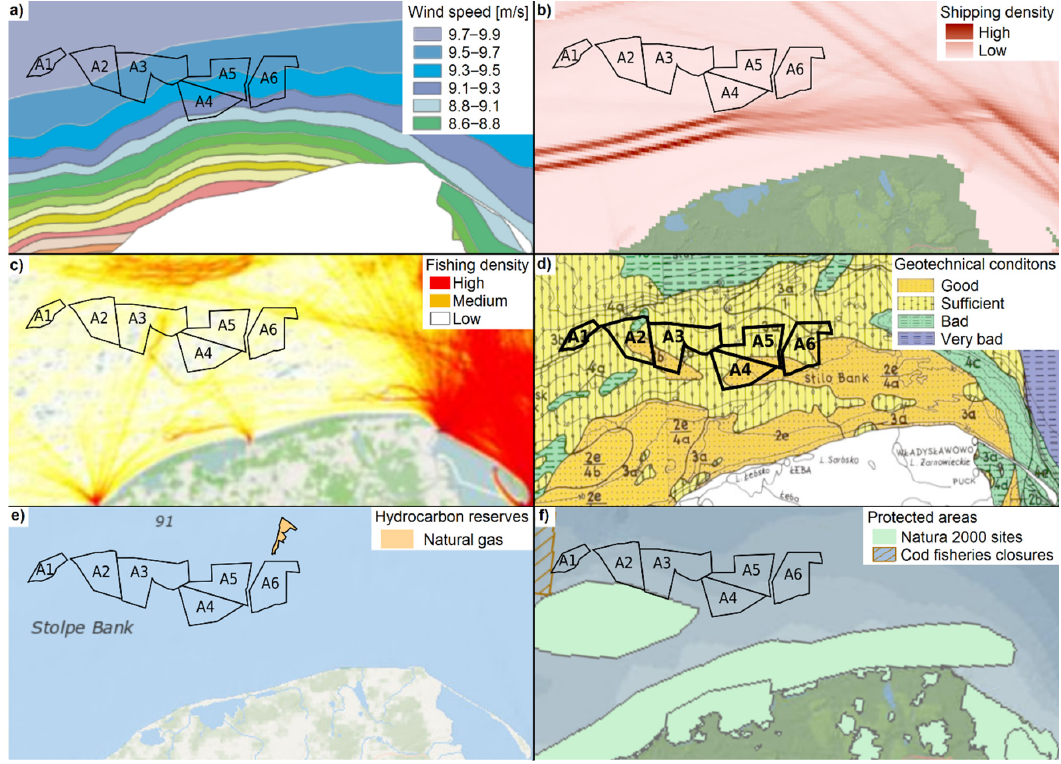
Figure 3. Decision-making alternatives in the problem of assessing planned offshore wind farms: A1–FEW Baltic II (RWE Renewables), A2–Baltic II (Polenergia and Equinor), A3–Baltica 2 (PGE), A4–Baltic 3 (Polenergia and Equinor), A5–Baltica 3 (PGE), A6–Baltic Power (PKN Orlen); ( a ) wind speed, ( b ) shipping density, ( c ) fishing density, ( d ) geotechnical conditions, ( e ) proximity to hydrocarbon reserves, ( f ) proximity to protected